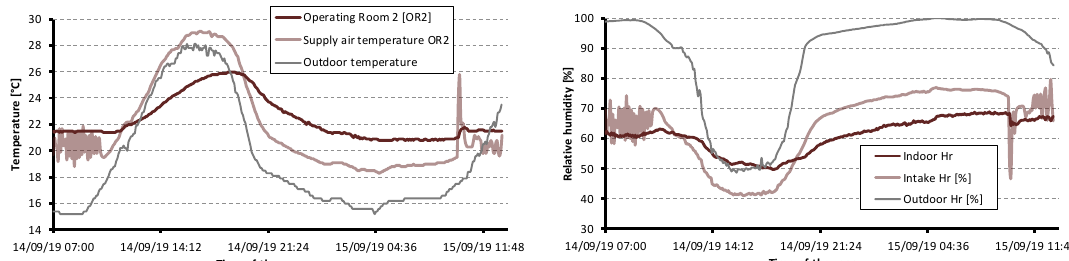
Figure 8. Temperature and RH in OR2 during the second experimental data campaign.